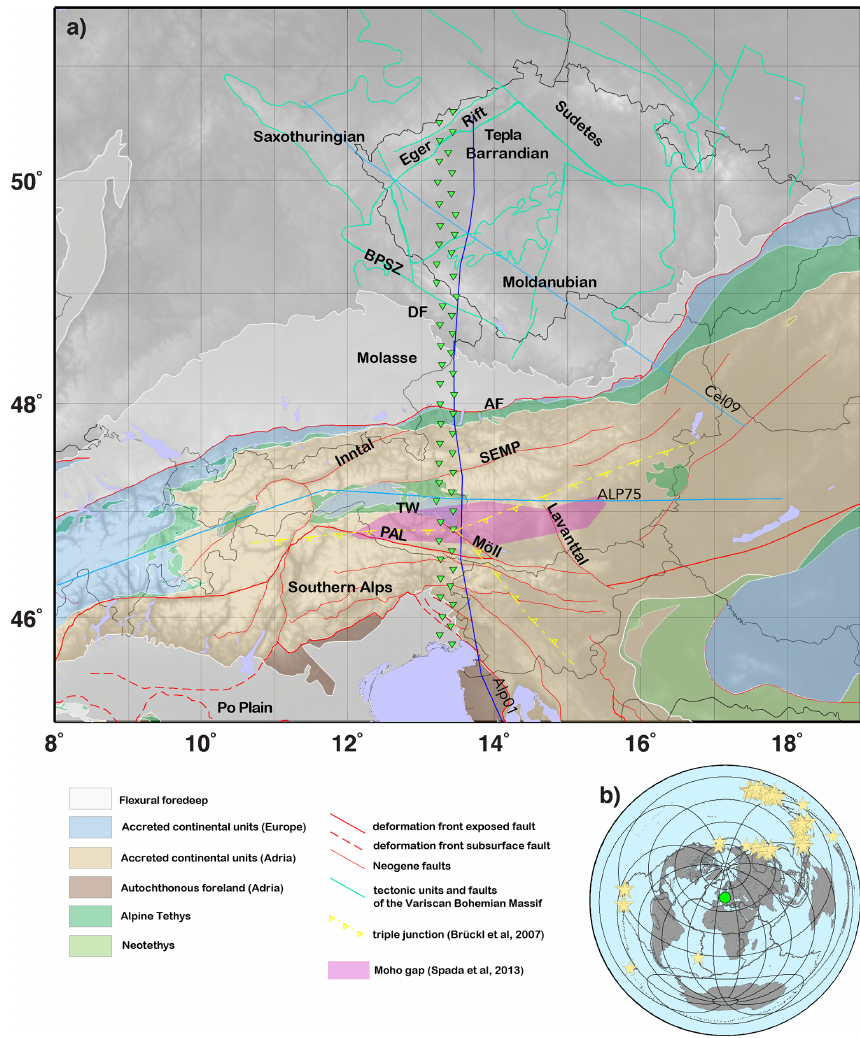
Figure 1. (a) Map of the wider study area showing the location of the seismic stations (green triangles) and the traces of previous active seismic profiles (ALP75, Cel09, Alp01). Colours on the background correspond to the generalized tectonic map of the Alps (Bigi et al., 1990; Bousquet et al., 2012; Froitzheim et al., 1996; Handy et al., 2010; Schmid et al., 2004, 2008). (b) Globe with the location of EASI transect (green) and epicentres of teleseisms used for GloPSI imaging (stars). Relief model of Earth’s surface used is ETOPO1 (NOAA National Geophysical Data Center, 2019; Amante and Eakins,